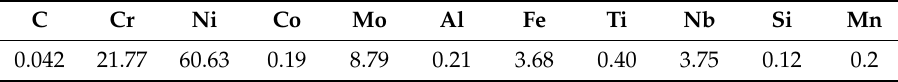
Table 1. The major chemical compositions of the Inconel625 (mass percent, wt %).